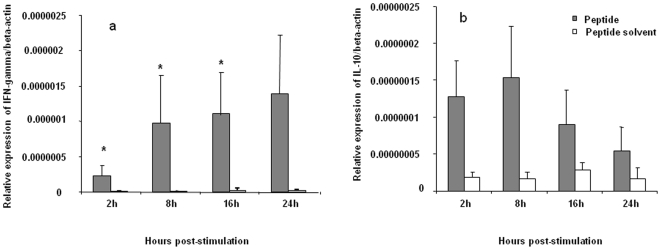
Cytokine mRNA expression in splenocytes in response to H5246–260.In three replicate experiments, spleen mononuclear cells from vaccinated birds were incubated with peptide or peptide solvent for 24 hours before RNA extraction and cytokine analysis using real-time PCR. Relative expression of IFN-γ (A), IL-10 (B) mRNA normalized to β-actin expression in stimulated and unstimulated spleen mononuclear cells are presented. Comparisons were made using the REST program and considered significant at P≤0.05 (*).